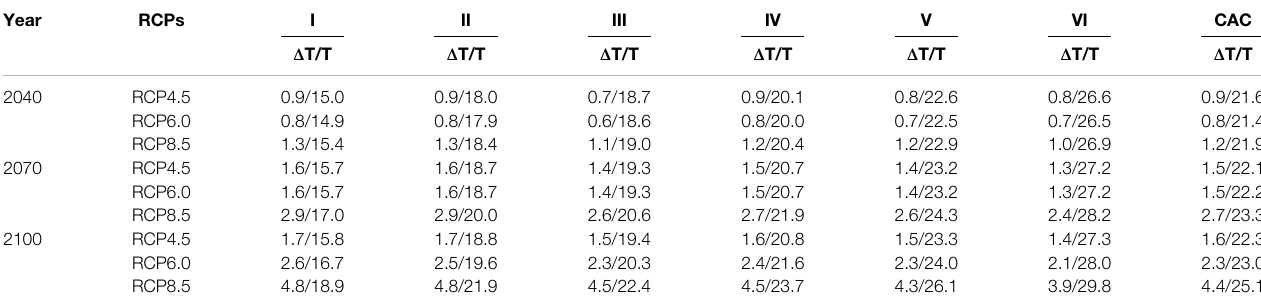
TABLE 4 | The changes of annual average Tmax relative to the base period 1996 – 2018 and the projected annual average Tmax for 2040, 2070, and 2100 with different RCPs over CAC (Unit: ° C).